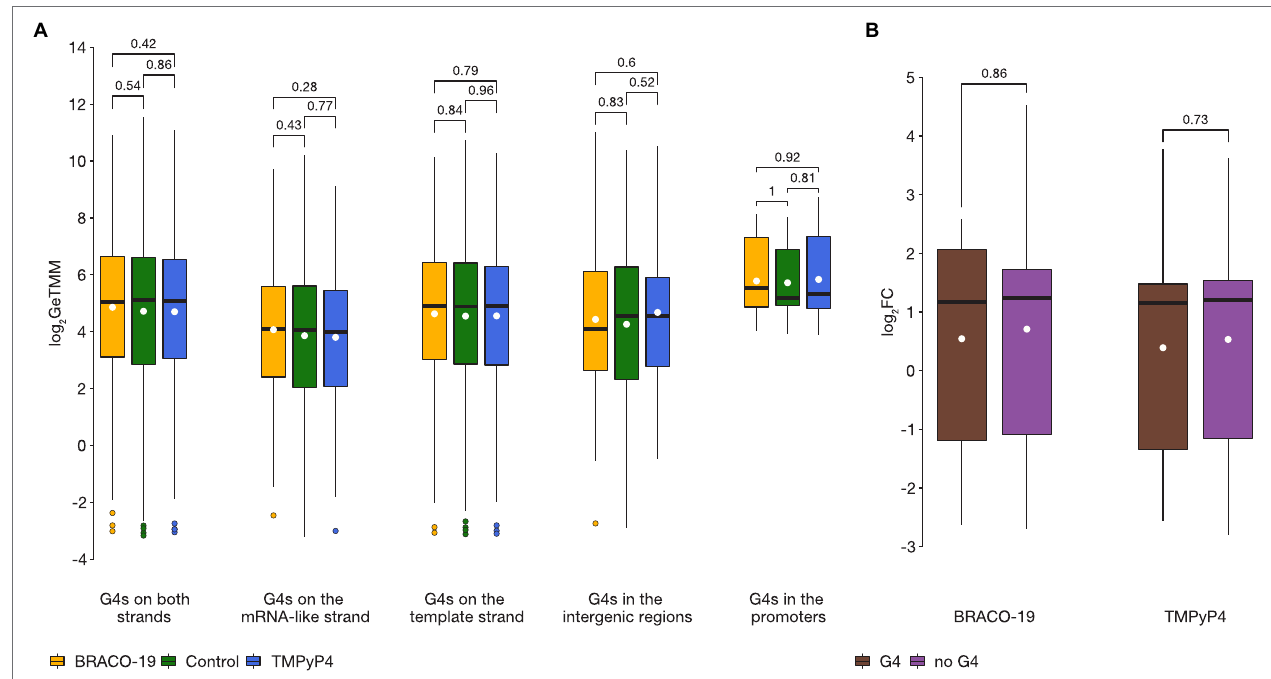
FIGURE 2 | There were no statistically significant differences in expression levels of genes containing G4 motifs between control and treated samples. (A) , A boxplot showing expression variance of G4-associated genes between control (green), on exposure to BRACO-19 (yellow), and on exposure to TMPyP4 (blue). The box shows the upper and lower quartiles, and the line within the box shows the median. The white dot indicates the mean. Points above the whiskers indicate outliers. Two-sided Wilcoxon rank-sum test with continuity correction was used to calculate values of p ; (B) , A boxplot showing the change in expression (log 2 FC) of co-regulated genes ( n = 191) observed by RNA-seq of M. smegmatis MC 2 155 exposed to BRACO-19 and TMPyP4 ligands. The box shows the upper and lower quartiles, and the line within the box shows the median. The white dot indicates the mean. Two-sided Wilcoxon rank-sum test with continuity correction was used to calculate values of p